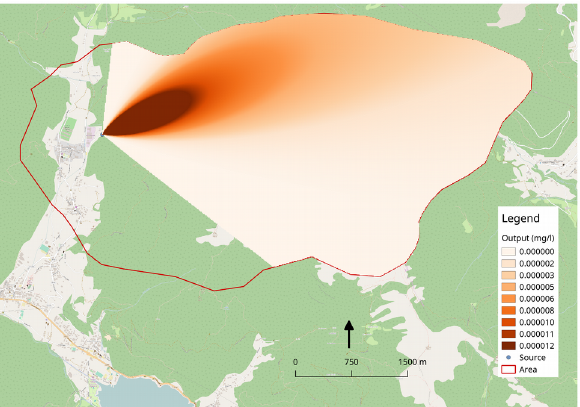
Figure 3. Example of output for the groundwater module; the concentration of Tetrachloroethylene is evaluated for the area inside the red line after the dispersion of 1 kg of substance.